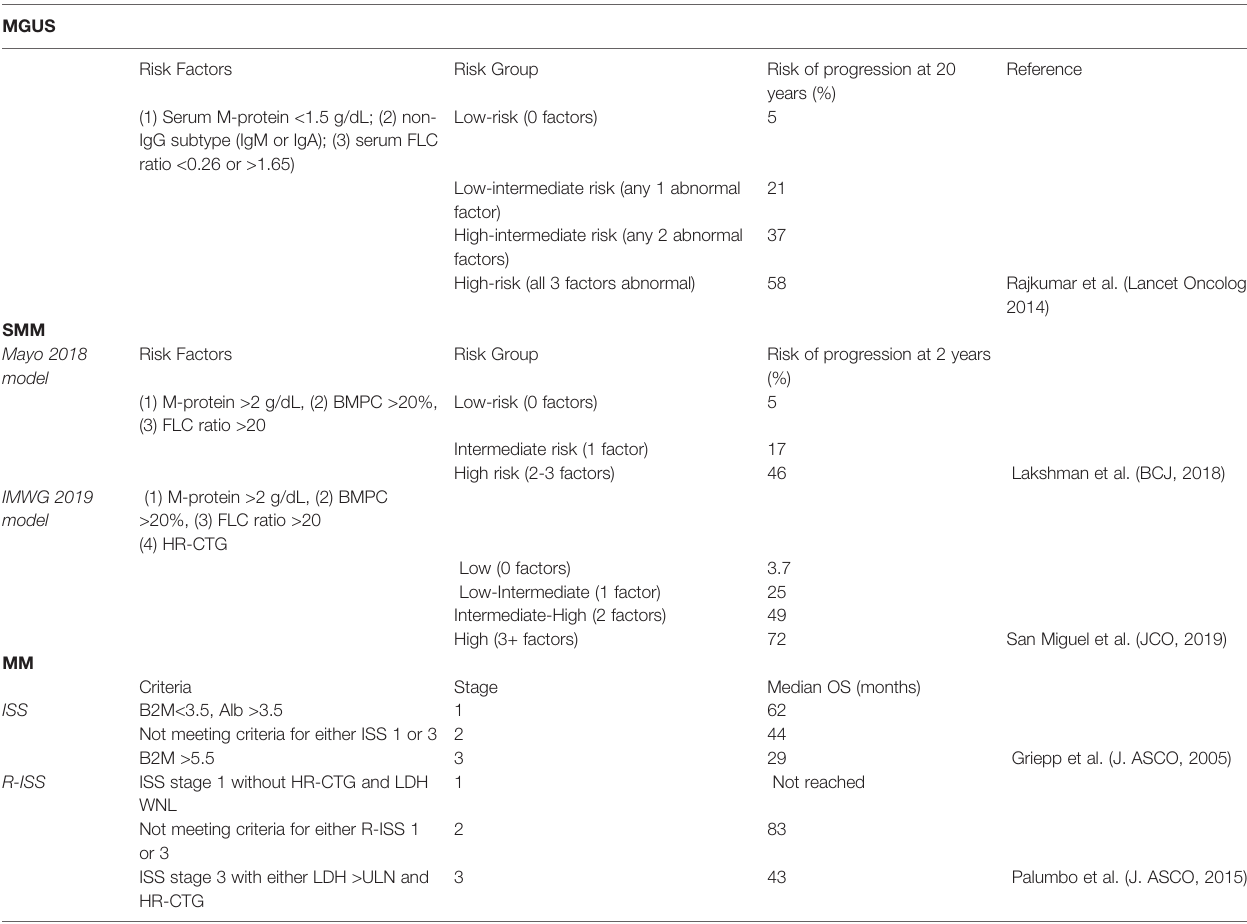
TABLE 1 | De fi ning stages of